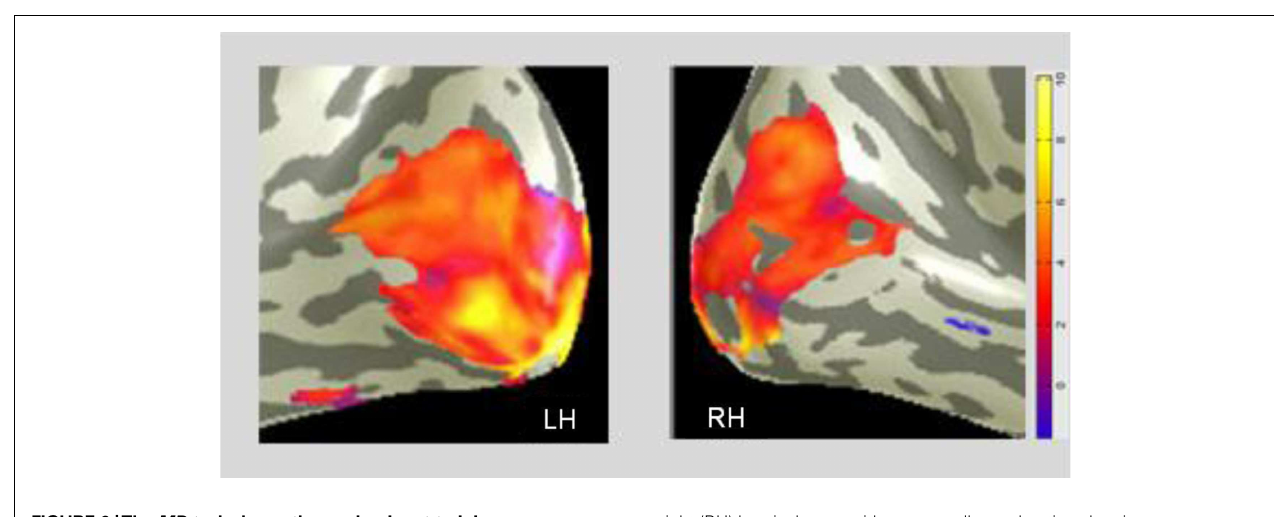
FIGURE 6 |The MD task shows the predominant training effect in the primary visual cortex. A voxel-wise comparison, projected on inflated representations of the posterior left (LH) and